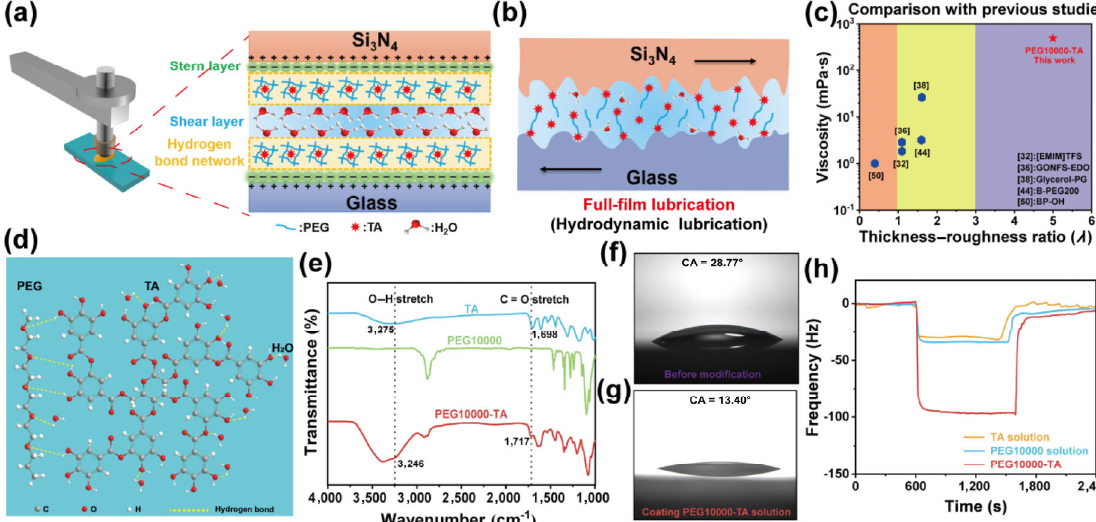
Fig. 9 (a) Possible superlubricity model of PEG10000-TA mixed solution. (b) Lubrication state during the superlubricity phase. (c) Comparison of the thickness–roughness ratio ( λ ) and viscosity in this work with previous studies. (d) Hypothetical interaction between PEG and TA molecules. (e) Infrared spectra of TA, PEG10000, and PEG10000-TA. The water contact angle on the surface of the glass sheet (f) before and (g) after coating with PEG10000-TA solution. (h) Frequency variation of QCM gold chips for lubricating materials (using pure water as the